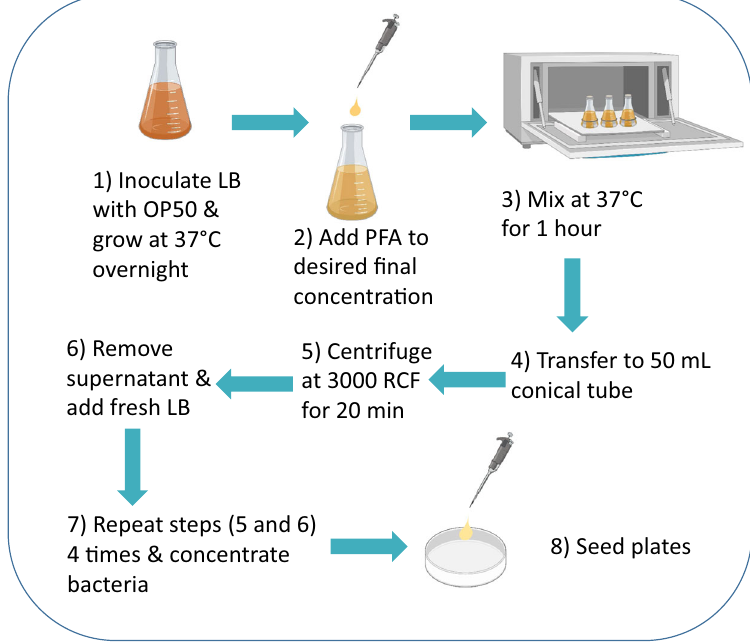
Fig. 1 Work fl ow of paraformaldehyde treated OP50. A single colony of E. coli OP50 bacteria is inoculated in lysogenic buffer (LB) and cultured overnight (18 h) in a 37 °C shaking incubator. The bacterial culture is then aliquoted into Erlenmeyer fl asks and 32% paraformaldehyde (PFA) is added to the aliquots to bring the fi nal PFA concentration down to 0.5%. The PFA-treated bacterial aliquots are then mixed in the 37 °C shaking incubator for 1 h to allow for even mixing and suf fi cient exposure to PFA. The aliquots are transferred to 50 mL conical tubes and centrifuged at RCF (relative centrifugal force) of approximately 3000 × g for 20 min and washed with 25 mL of LB fi ve times. The aliquots are concentrated 10-fold for lifespan assays and 5-fold for other downstream applications and seeded on the NGM plates.